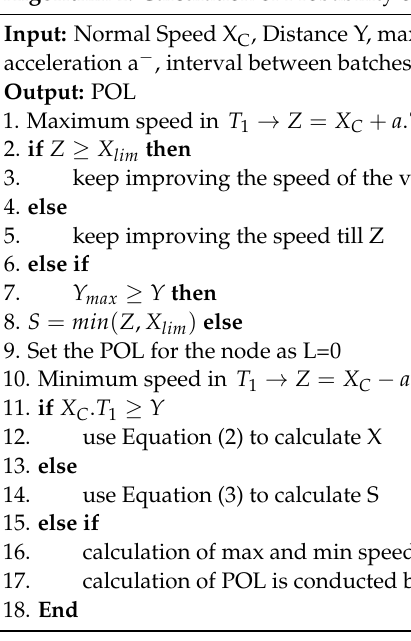
Algorithm 1: Calculation of Probability of Leaving